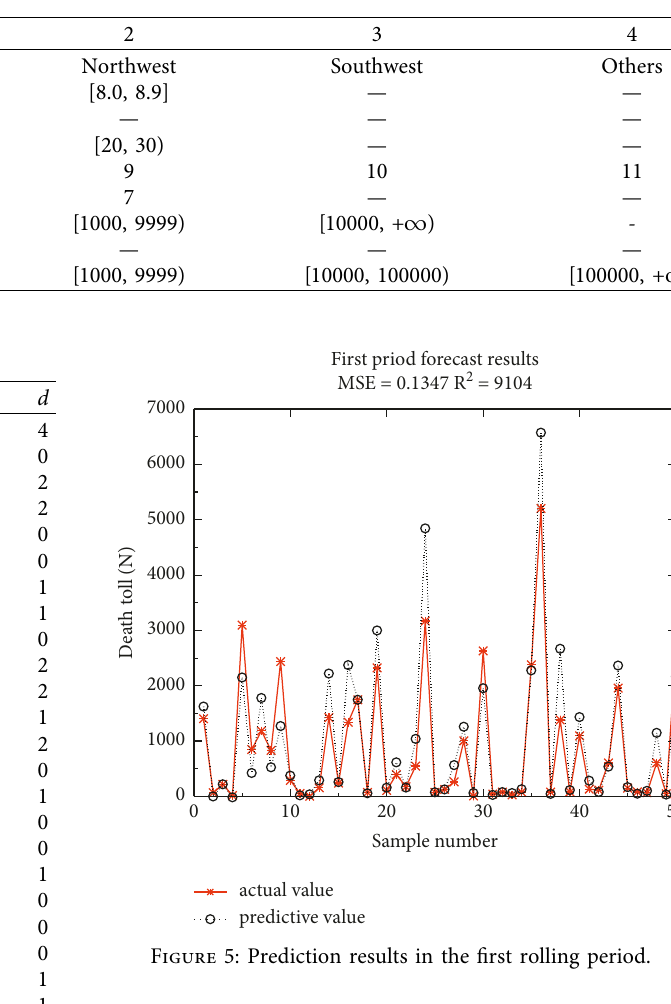
Table 7: Discretization rule of index attributes.